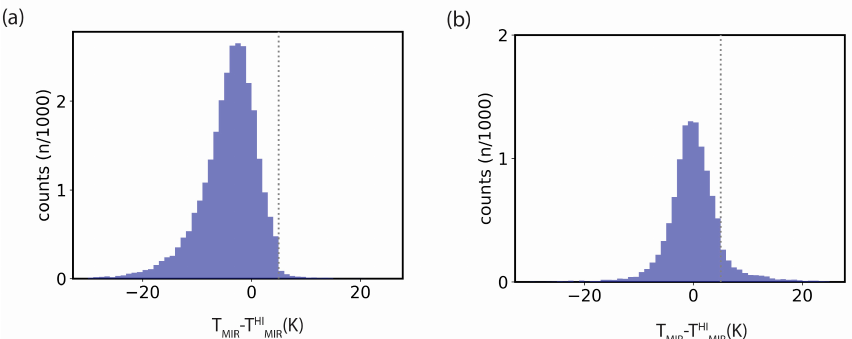
Figure 5. Demonstrating MODIS hotspots below the level of detectability using AHI values and BRIGHT statistics. AHI T MIR and BRIGHT T HI values were taken at all BRIGHT-to-MODIS (MODIS) unmatched hotspot times/locations. Then the AHI T MIR -BRIGHT T HI statistics were during the day ( a ) and night ( b ) and plotted (using 1 K bins). The grey dotted line at T MIR − T HI = 5 indicates the level below which no AHI hotspots can be detected (using BRIGHT T HI thresholds). Note, the x -axis is artificially cut off at BRIGHT T MIR − T HI = 30 K for demonstration purposes. 3.3. Disagreements during Burning Periods Hotspot counts were collated for individual biodomains (using ancillary IBRA infor- mation) and calendar months. Counts were calculated for all BRIGHT-to-VIIRS, BRIGHT- to-MODIS daytime (night-time) combinations. The results were sorted in descending or- der, according to the number of raw hotspots. Biodomain identifiers were then collected until at least 50% of the raw hotspot activity (for each BRIGHT-to-VIIRS, BRIGHT-to- MODIS, day/night combination, separately) were accounted for. The biodomain identifi- ers were reduced to one set (Figure 6; white and grey regions). The counting and sorting processes were repeated for unmatched hotspots. The unmatched hotspot regional identifi- ers included most of the raw fire activity regions, plus some additional ones (Figure 6; white and pink regions; for a description of the biodomains see Figure 6). The biodomains were grouped into spatial regions (southeast, southwest, central- north, and northeast Australia) against which raw and unmatched counts per month were plotted (see Figures 7 and 8). The monthly patterns remained relatively stable within each of the four distinct spatial biodomains, but varied between them.